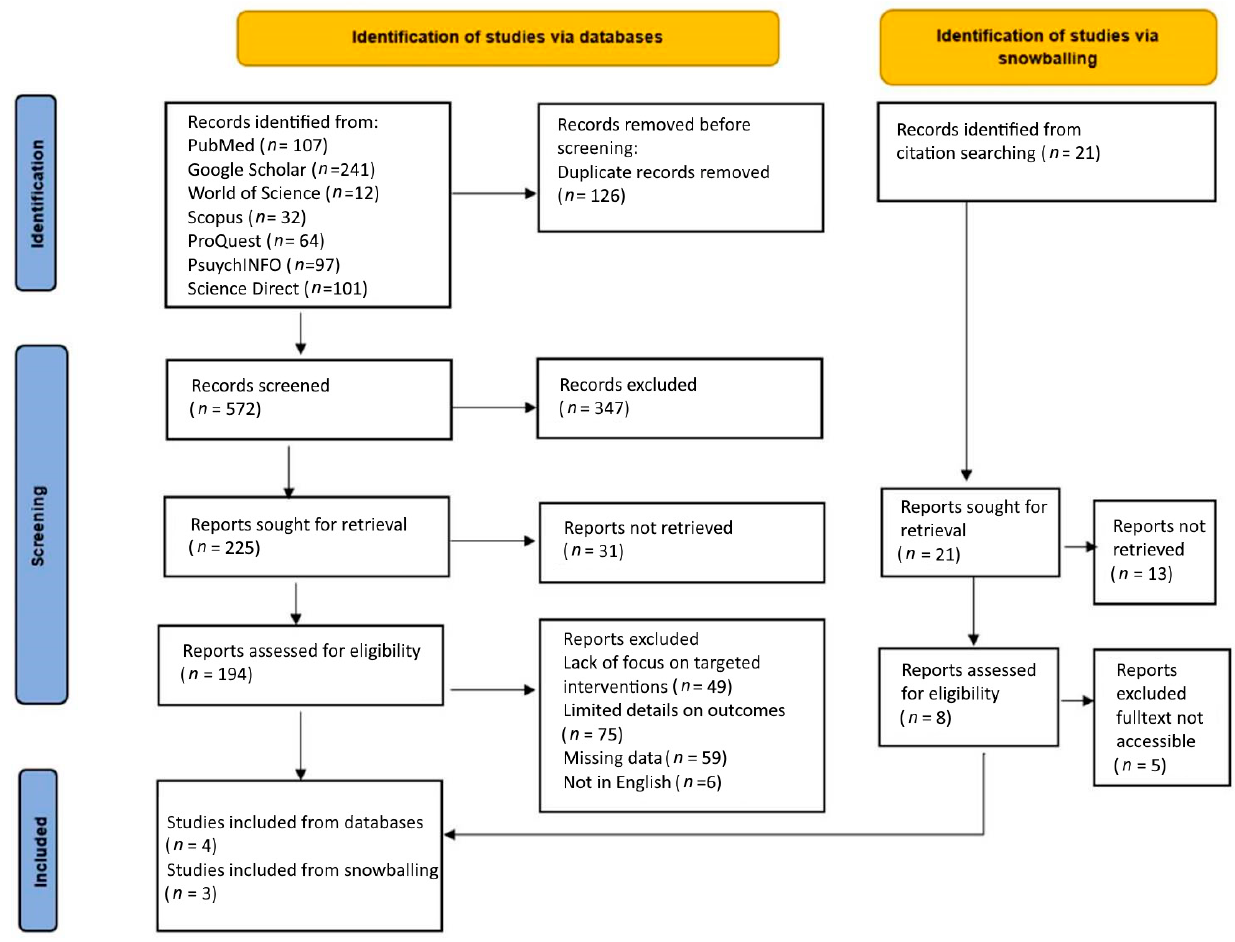
Figure 1. PRISMA diagram.